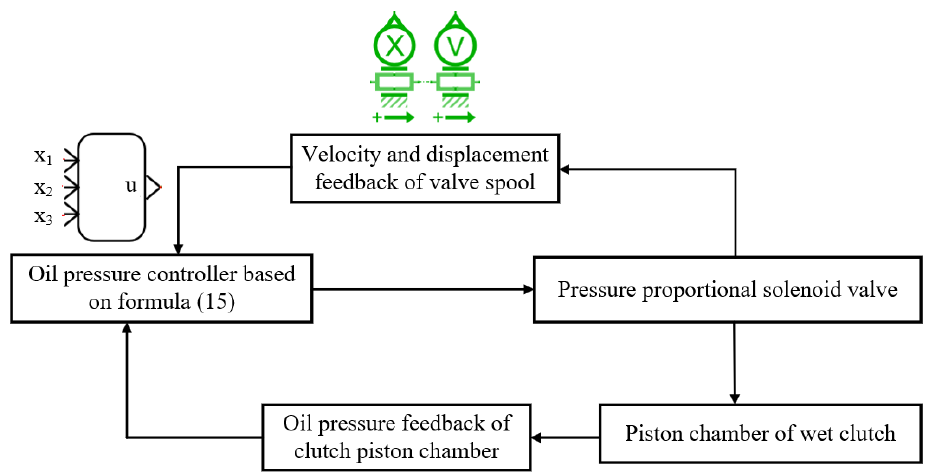
Figure 3. The hydraulic control simulation platform based on formula (15) of the wet clutch.